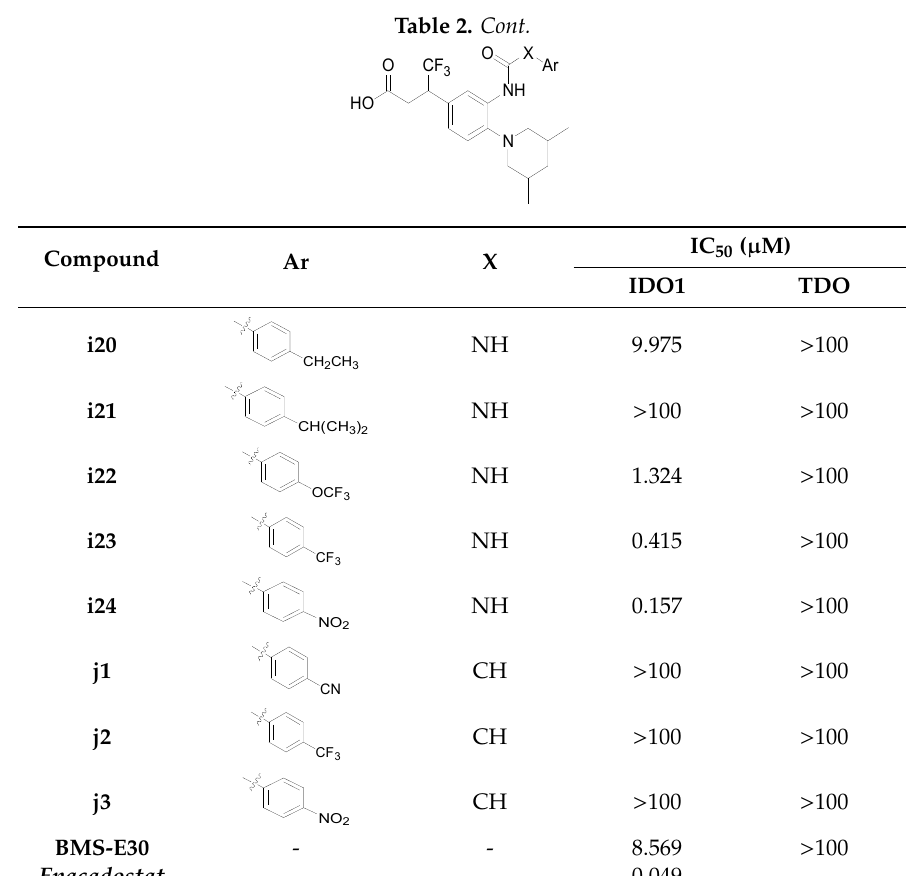
Table 2. IC 50 values of compounds i1–i3 , i6–i24 and j1–j3 against IDO1 and